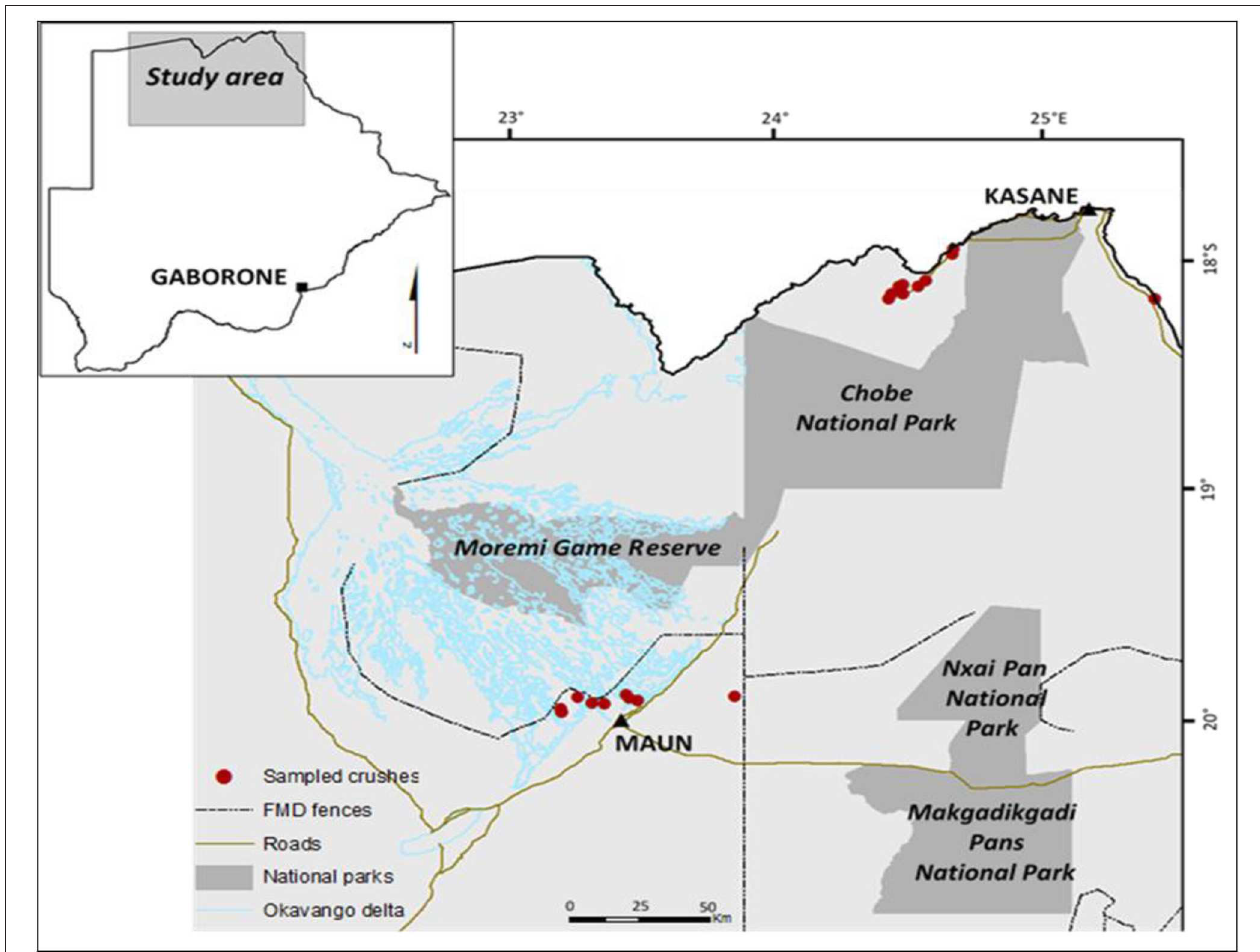
FIGURE 1 | Map showing location of sampling sites (Maun west and Chobe west) in northern Botswana.